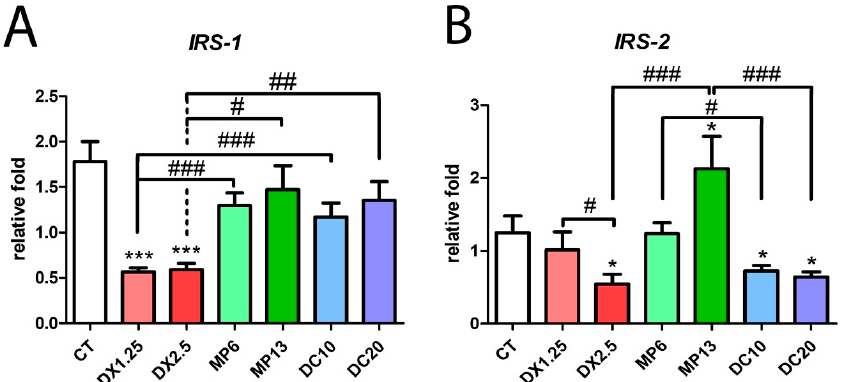
Figure 5. mRNA expression by RT-PCR of IRS-1 ( A ) and IRS-2 ( B ) after the administration of different glucocorticoids. (*) represents the statistical difference in comparison to the CT and (#) represents statistical difference between groups. Legend: * or # = P < 0.05; ## = P < 0.01 and *** or ### = P < 0.001. ( n per group: CT = 10, DX1.25 = 9, DX2.5 = 8, DC10 = 10, DC20 = 10, MP13 = 8, MP6 = 8).